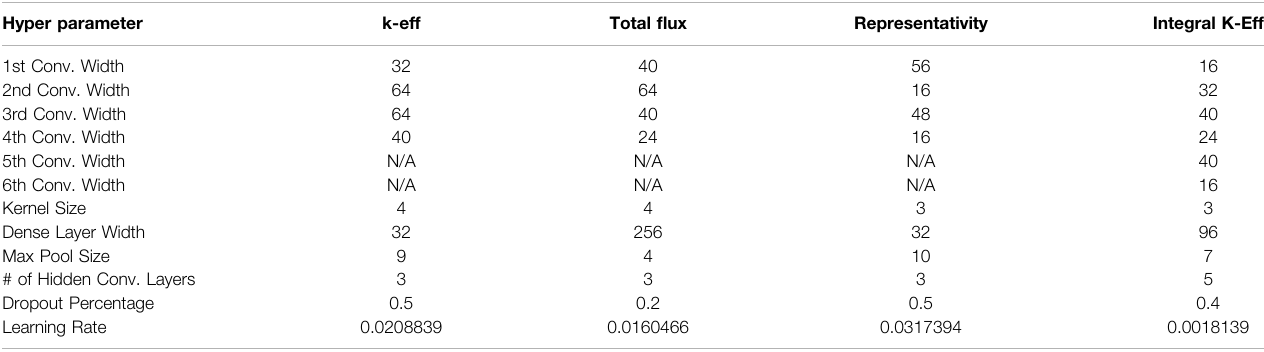
TABLE 3 | FNS CNN surrogate model